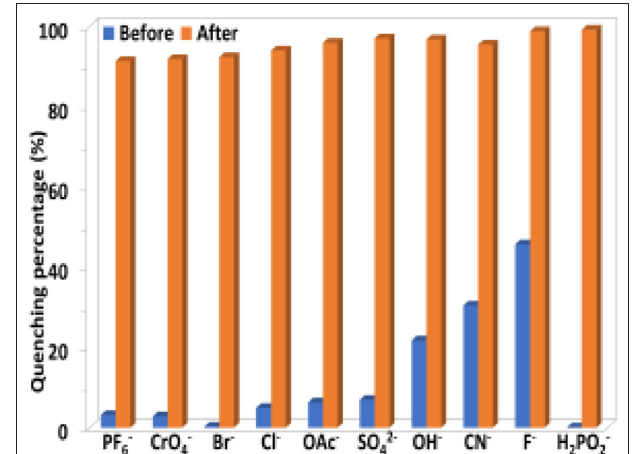
FIGURE 8 | The luminescence quenching percentages of 1 (0.5 µ M) before and after the addition of H 2 PO 2 − (5 µ M) in the presence of other anions (5 µ M) in CH 3 CN.